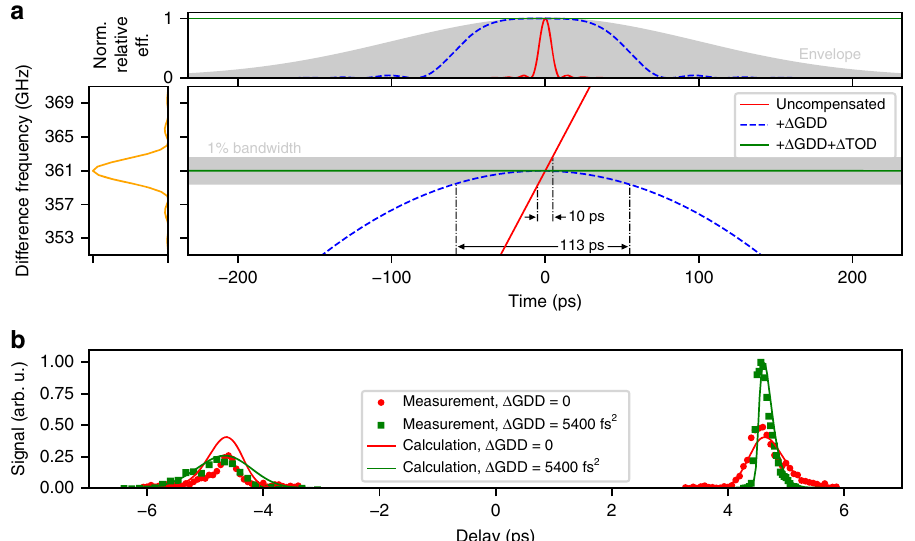
Fig. 4 Asymmetric chirp compensation. a The 330 µ m poling period PPLN has a central frequency of Ω THz = 361 GHz with a 1% bandwidth. Initially, the difference frequency Δ ω varies linearly in time (red). As spectral phase compensation is applied adding Δ GDD (dashed blue) and further adding Δ TOD (solid green) the fraction of the pulse falling within the THz bandwidth Ω THz ± Δ Ω THz , and thus the generated THz energy, increases. The top inset shows the PPLN bandwidth multiplied by the difference frequency. The integrated product of this phase-matching ef fi ciency with the pulse envelope (grey) is a measure for the fraction of the pulse contributing to THz generation. b Adding Δ GDD (green) creates an asymmetry between the two pulses in time that reduces the THz signal at negative delays and enhances the THz at positive delays. For identical pulses (red) the THz signal is equal for positive and negative delays. A calculation (solid lines) based on the concept discussed in the main text and illustrated in panel a predicts the THz output in good agreement with the measurements (squares, dots)